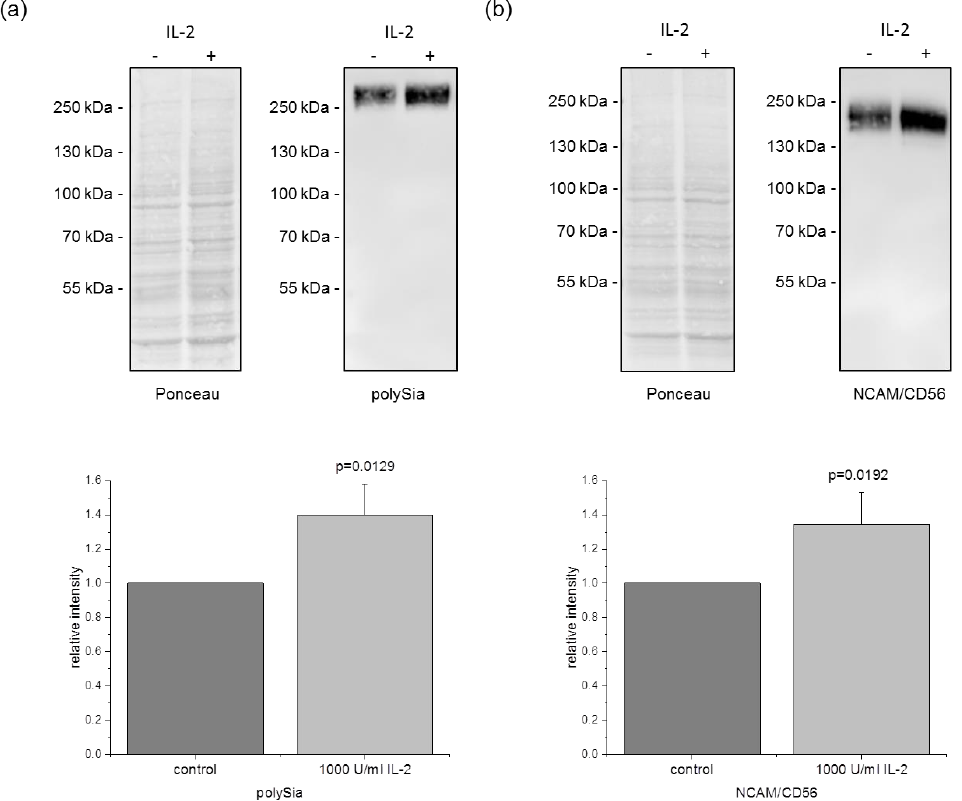
Figure 4. Western blot analysis of polySia and NCAM / CD56 after IL-2 activation. NK-92 cells were incubated without IL-2 for 24 h and analyzed directly (control) or treated with 1000 U / mL IL-2 for additional 24 h. Proteins were isolated, separated via SDS-PAGE and analyzed by Western blot. ( a ) Relative polySia intensity before and after treatment is shown. ( b ) For analysis of NCAM / CD56, samples were treated with endo-N-acetylneuraminidase E (endoNE) prior to separation. Graphs show average mean ± SD of 5 independent experiments and blots are representative.